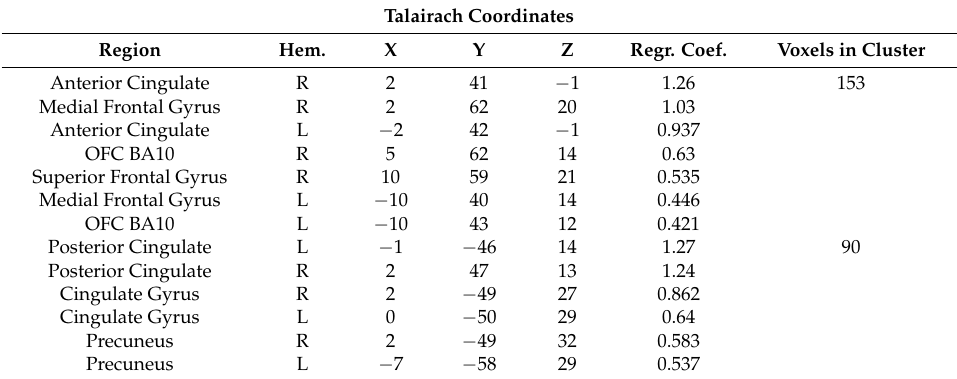
Table 6. Regions of significantly greater activity in caffeine non-consumers compared to caffeine consumers while judging the pleasantness of sucrose.